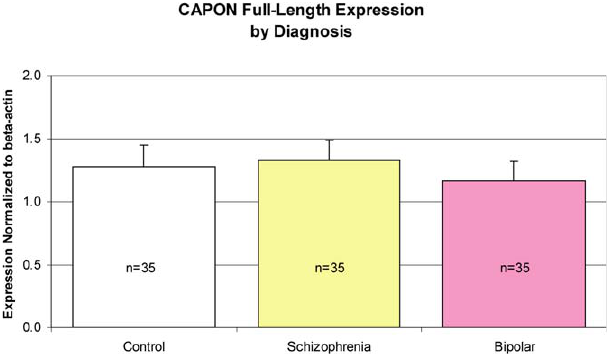
Figure 4. ACTB (Beta-Actin)–Normalized CAPON mRNA Short-Form Expression by Diagnosis Expression levels are least squares means. Mean values per category are plotted with 95% confidence intervals. The number of individuals per sample is indicated within each bar. Expression is significantly higher in patients with schizophrenia ( p ¼ 0.0013) and bipolar ( p ¼ 0.0009) as compared to controls. The mean (95% confidence interval lower bound, upper bound) for the control, schizophrenia, and bipolar groups are 1.34